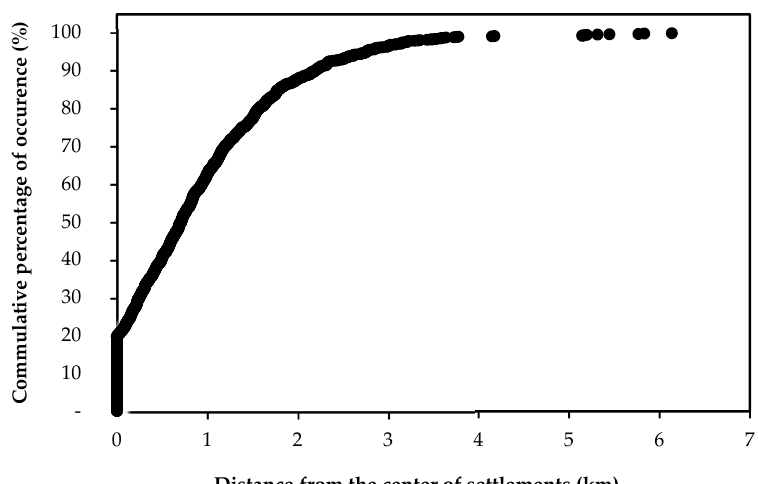
Figure 5. Cumulative occurrence records of Solanum elaeagnifolium in relation to the distance from the center of Greek settlements.